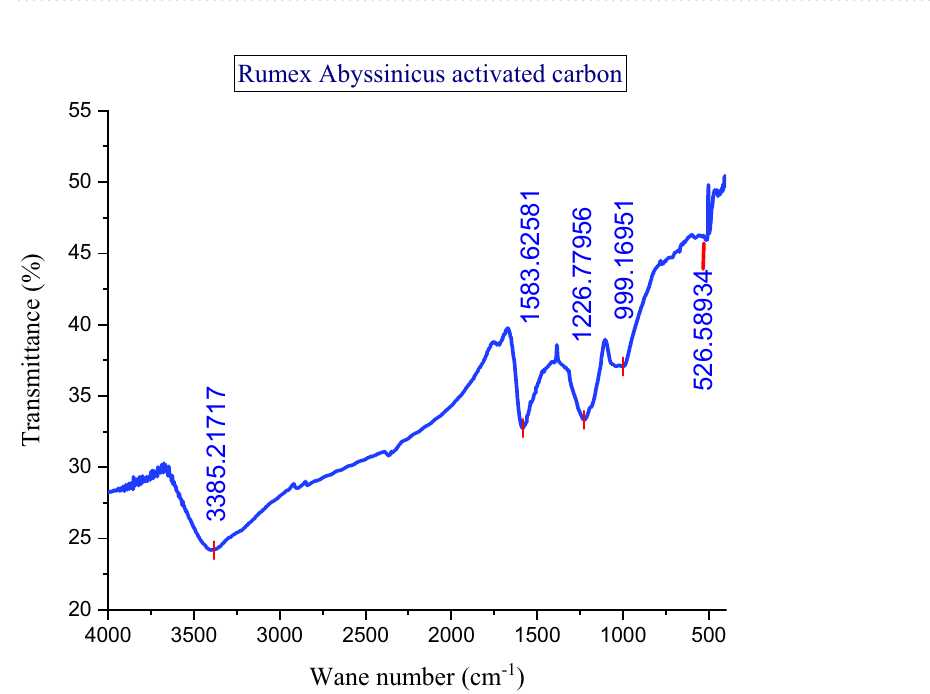
Figure 4. FTIR Analysis of Rumex abyssinicus activated